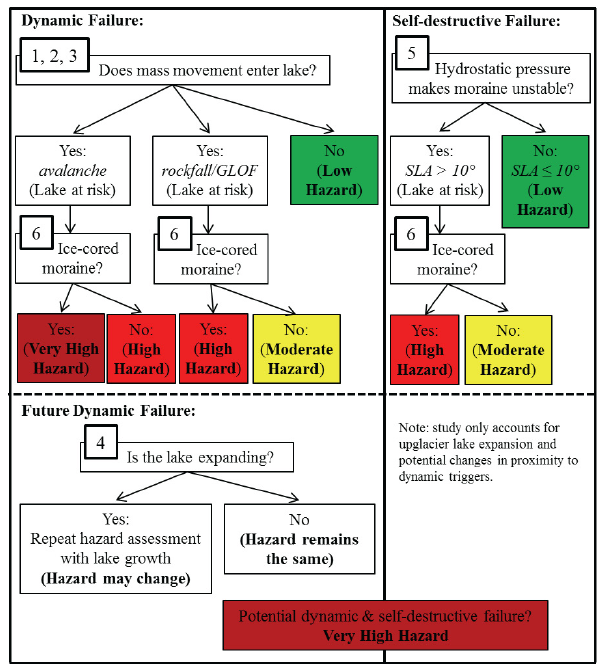
Figure 4. Hazard classification flow chart for determining the haz- ard associated with a glacial lake (numbers refer to hazard parame- ters in Fig. 2).